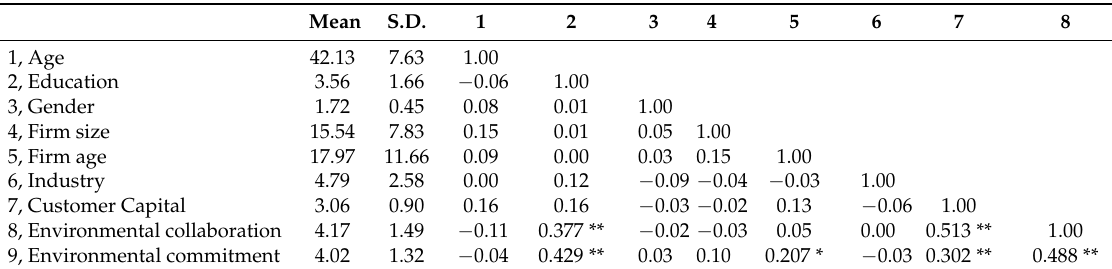
Table 1. Correlation and Descriptive